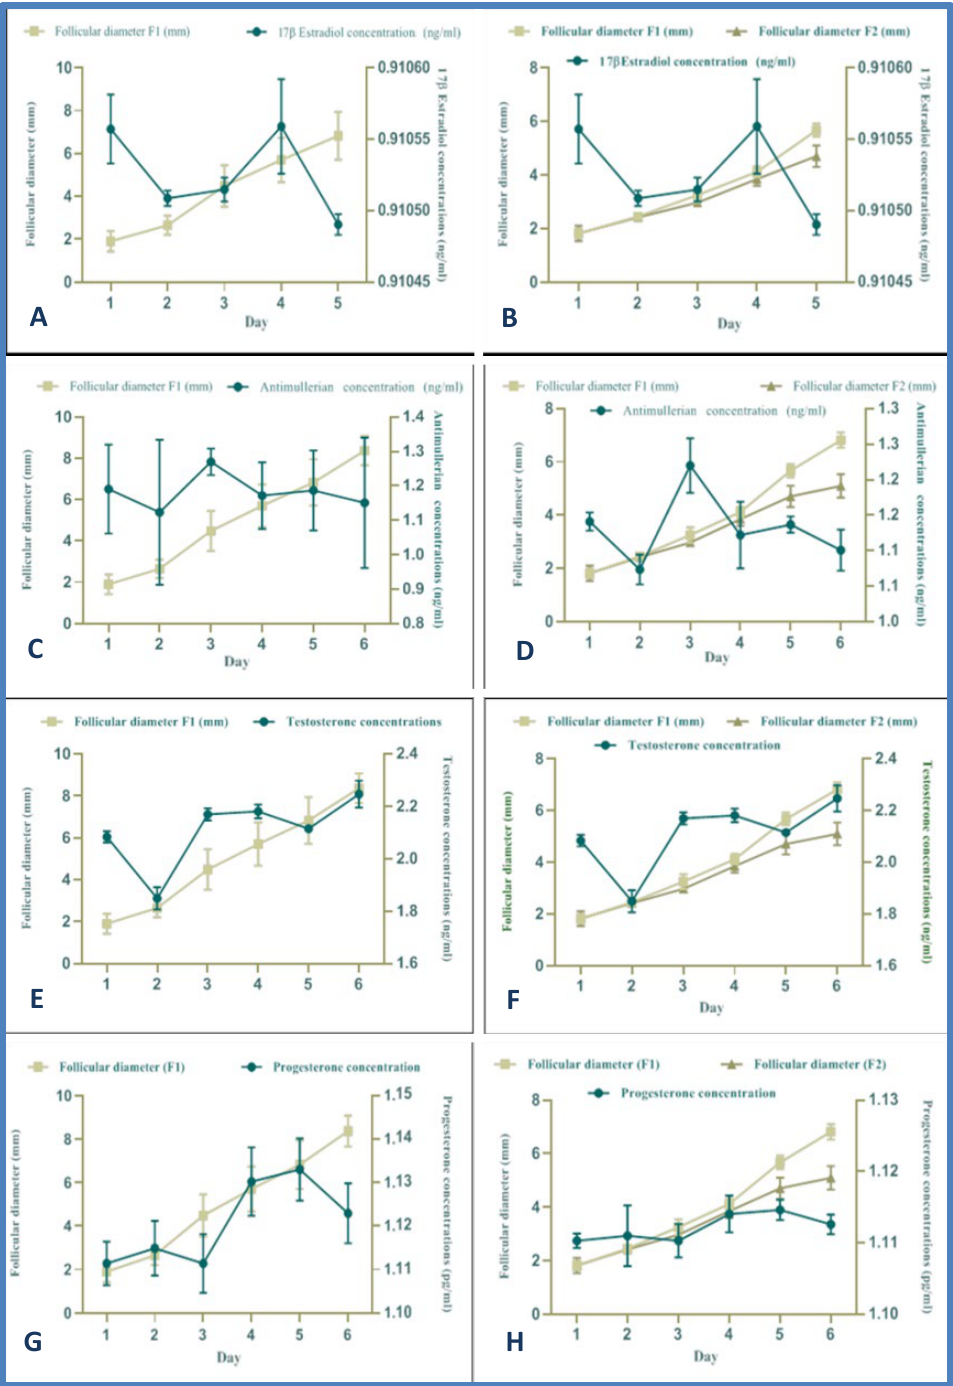
Figure 3. Follicle diameter vs. 17β estradiol ( A , B ), anti-Mullerian ( C , D ), testosterone ( E , F ), and progesterone ( G , H ) concentration in relation with the duration of the follicular deviation (single DF vs. codominance) in llamas ( Lama glama ). Single DF (left; A , C , E , G ) vs. codominance (right; B , D , F , H ). Mean (± S.E.M.) follicular diameter (mm) and serum hormone concentration (ng/mL) from day 1 to day 6 in llamas.